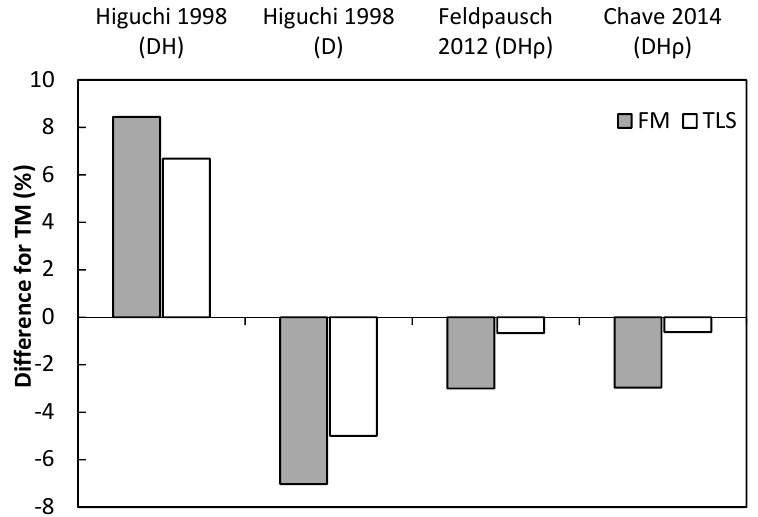
Figure A3. The difference among estimates of the total aboveground biomass using data obtained from tape measurements (TM) vs. Fieldmap bundle (FM) or terrestrial laser scanner (TLS) and respective allometric equations (listed in Table A1).